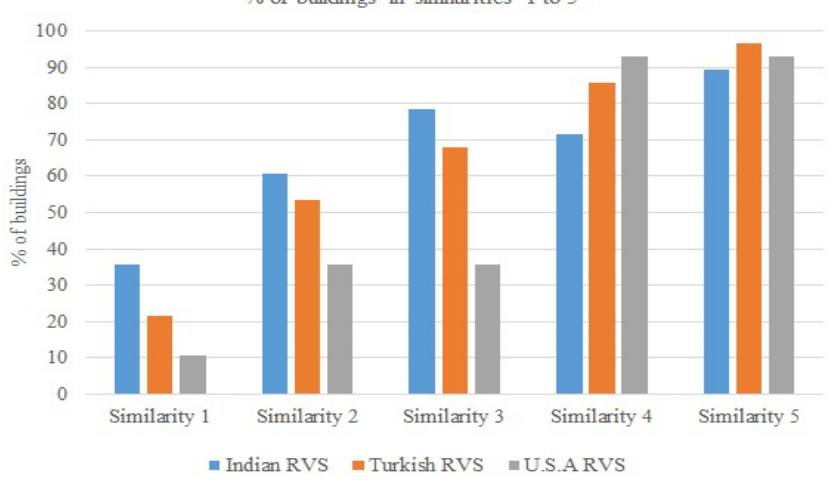
Figure 3. Percentage of buildings in each similarity from RVS